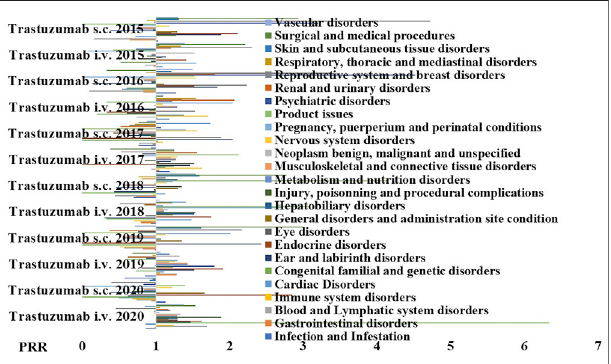
FIGURE 4 | PPR distribution of trastuzumab s.c. and i.v. formulations duringtheperiodofobservationof2015 – 2020.PRR ≥ 2indicatesahighriskof ADRforaspeci fi cS.O.C.Trastuzumabi.v.showedPRR ≥ 2forproductissues (X 2 > 4), general disorder and administration site conditions (X 2 > 4); trastuzumab s.c. showed PRR ≥ 2 general disorders and administration site condition (X 2 > 4), product issues (X 2 > 4), infection and infestation (X 2 < 4, n.s.);musculoskeletalandconnectivetissuedisorders(X 2 > 4),andpsychiatric disorders (X 2 >